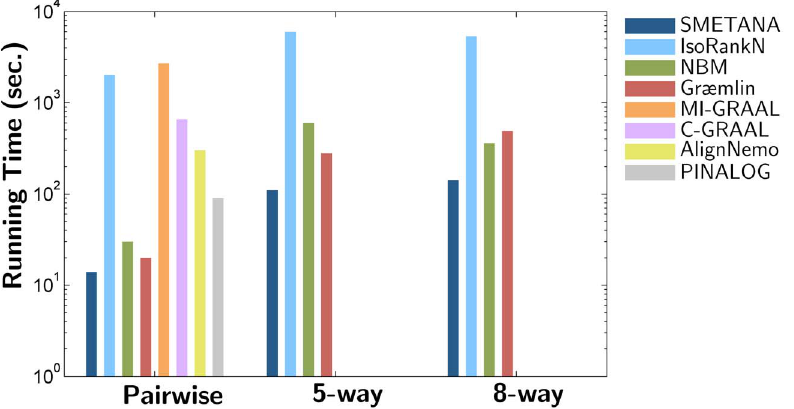
Figure 5. Total CPU time for aligning the networks. The total CPU time for the pairwise, 5-way, and 8-way alignments. CPU time has been averaged over DMC, DMR, and CG datasets (measured in seconds).